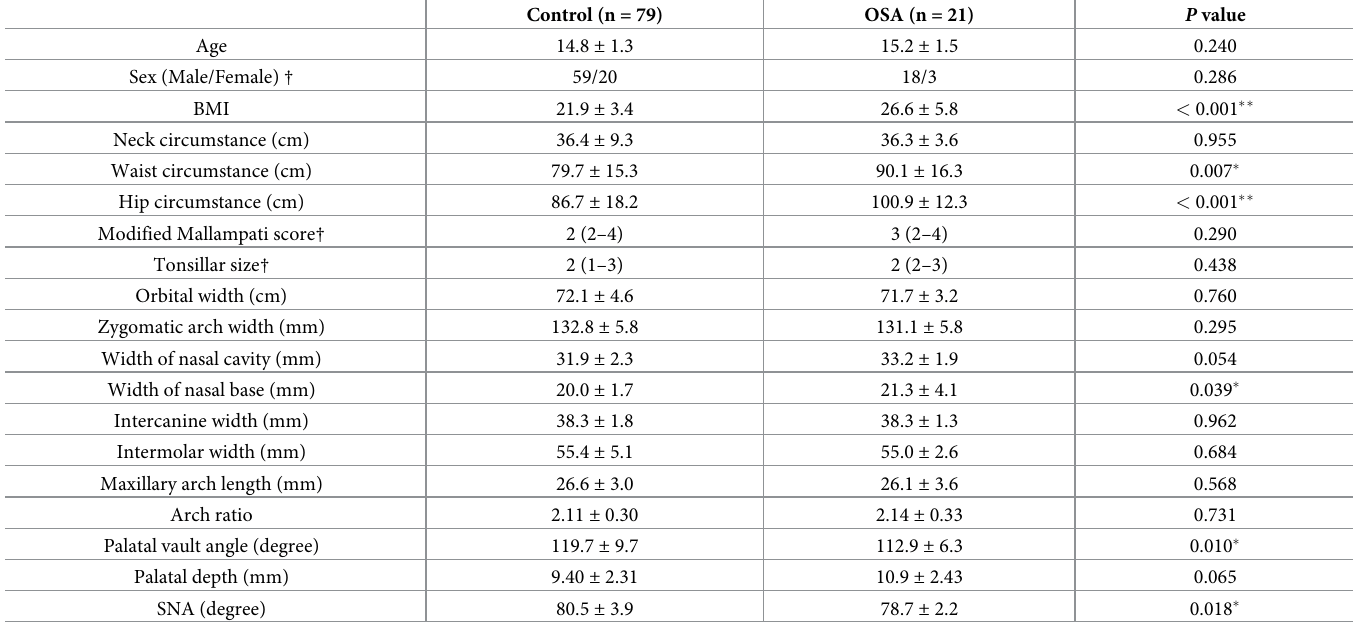
Table 1. Comparison of clinical characteristics related to the development of OSA.